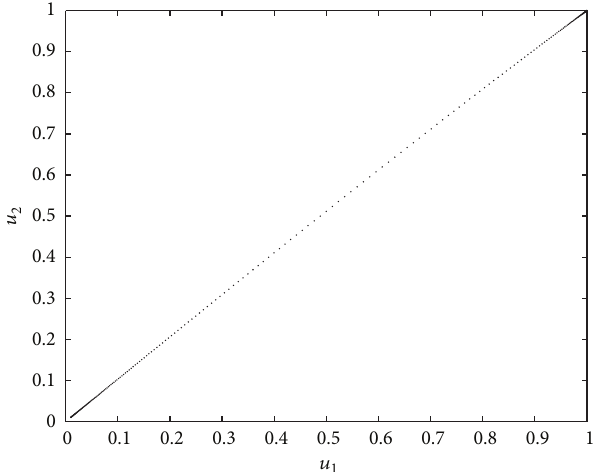
Figure 1: 2D computer simulation result shows simple dynamical behaviors of the uncontrolled system (6) in the (𝑢 1 , 𝑢 2 ) space for 𝑘 = 1 , and 𝑛 from 0 to 20000, with the initial condition 𝑢(0) = (0.01, 0.01) 𝑇 .